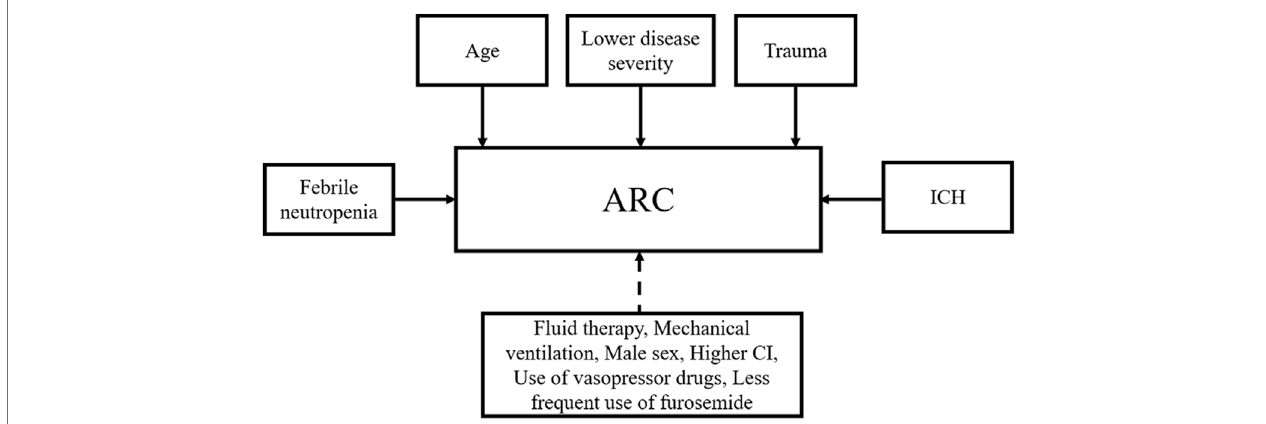
FIGURE2| ThepossiblepathogenesisofARCinsevereinfection.ARC,augmented renalclearance;SIRS,systemic in fl ammatory responsesyndrome;RBF,renal blood fl ow; CO, cardiac output; GFR, glomerular fi ltration rate.